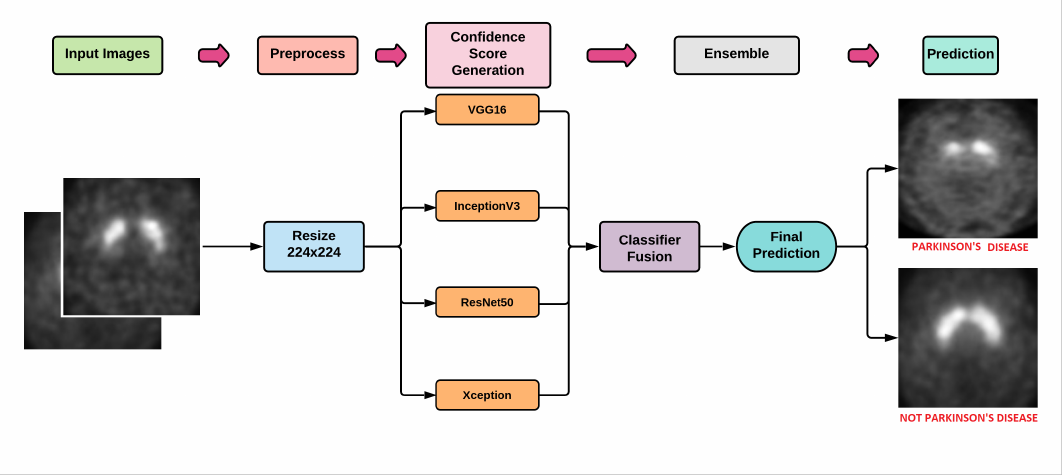
Figure 3. Workflow of the proposed work.